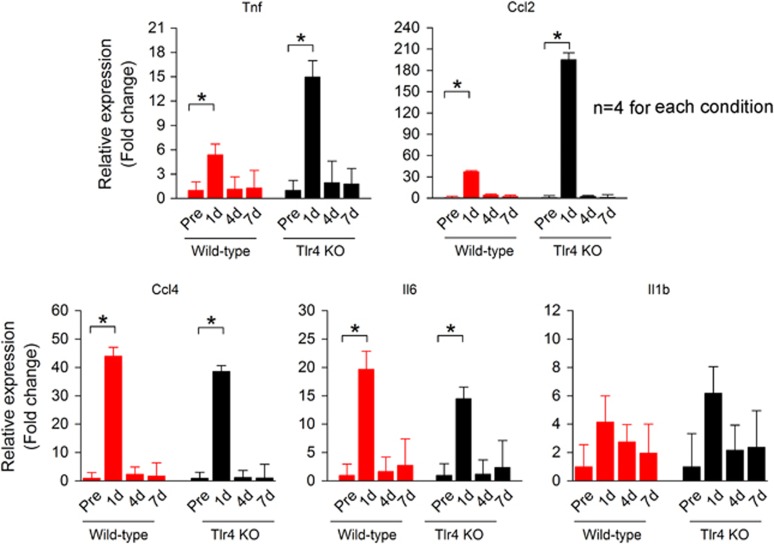
The transcriptional expression of pro-inflammatory genes in non-organ of Corti tissues after acoustic injury. The expression of five pro-inflammatory genes (Tnf, Ccl2, Ccl4, Il6 and Il1b) was examined in cochlear samples containing the lateral wall and the basilar membrane tissues before and at three time points (1, 4 and 7 days) after acoustic injury. In wild-type mice (red columns), all examined genes exhibited time-dependent upregulation after acoustic injury. Four genes (Tnf, Ccl2, Ccl4 and Il6) exhibited significant upregulation at 1 day post noise exposure (one-way ANOVA with Tukey test for pairwise comparison, P<0.05). Il1b expression is also increased at this time point, but the difference is not statistically significant. At 4 and 7 days after acoustic injury, the expression levels of the examined genes return to the pre-noise levels. Black columns illustrate the expression changes observed in Tlr4−/− mice. These mice display a similar pattern of expression, with a significant upregulation at 1 day after acoustic injury for all examined genes except for Il1b (one-way ANOVA with Tukey test for pairwise comparison, P<0.05). Again, the expression levels at 4 and 7 days after acoustic injury return to or close to the pre-noise level. These observations suggest that loss of Tlr4 does not attenuate the inflammatory response in non-organ of Corti tissues